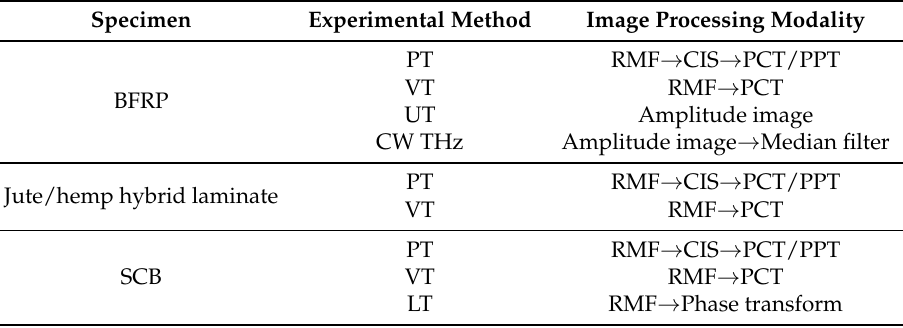
Table 6. Applied experimental and image processing methods.